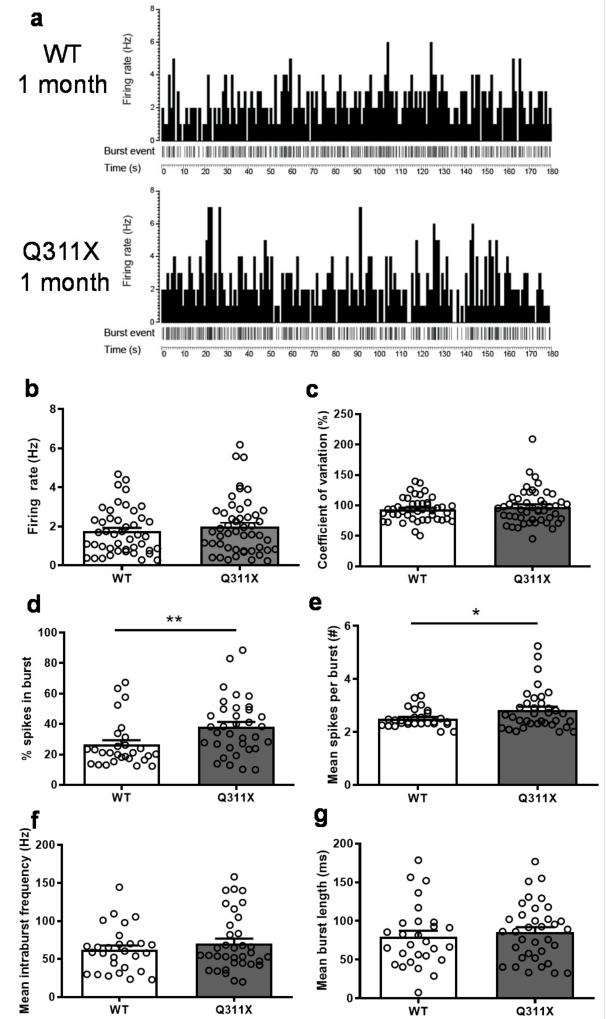
Figure 2. Burst activity of SNc DA neurons is increased in parkinQ311X mice. ( a ) Representative histograms of spontaneous single-neuron firing rate activity (first trace) and burst event (second trace) in WT and parkinQ311X mice at 1 month of age. ( b , c ) The mean spontaneous firing activity and the coefficient of variation (COV) of SNc DA neurons were similar in WT and parkinQ311X mice. ( d , e ) The percentage of spikes in burst and the number of spikes per burst were higher in parkinQ311X mice than in WT mice. ( f , g ) The mean intraburst frequency and the mean burst length were similar in WT and parkinQ311X mice. Data are mean ± SEM of 45 neurons from 10 WT mice and 49 neurons from 10 parkinQ311X mice. * p < 0.05 and ** p < 0.01, different from WT mice (unpaired Student’s t